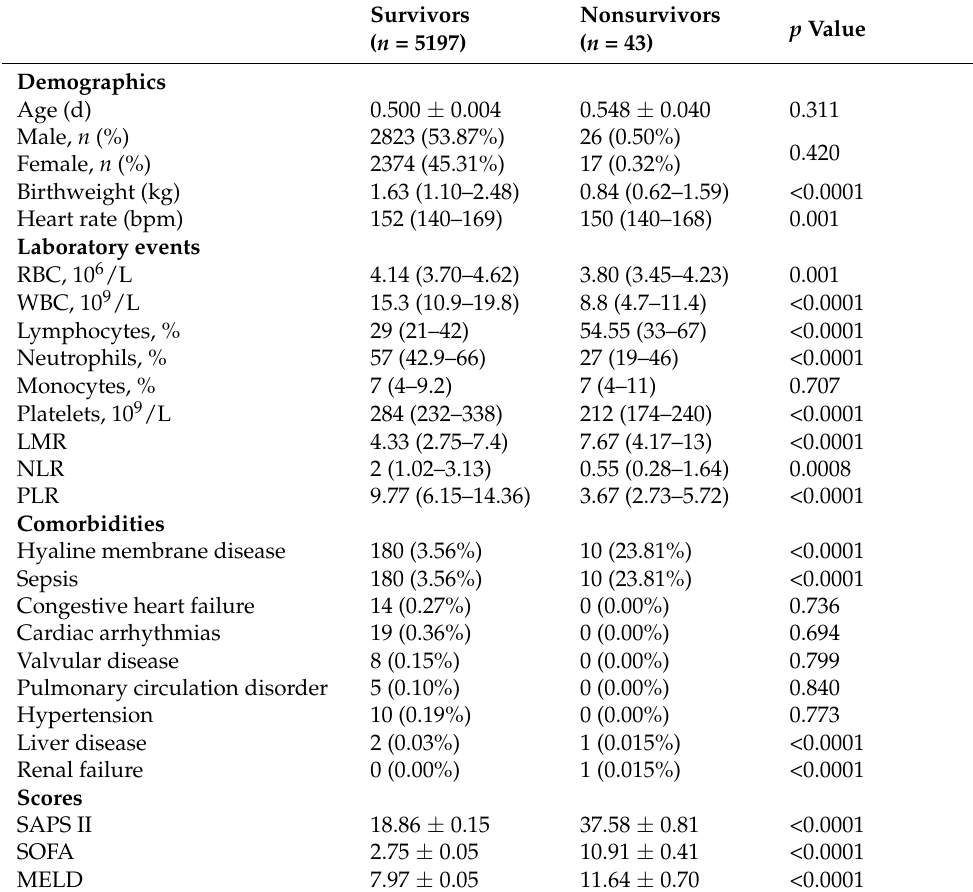
Table 1. Baseline characteristics of the study population with different survival status in hospital. Survivors ( n =